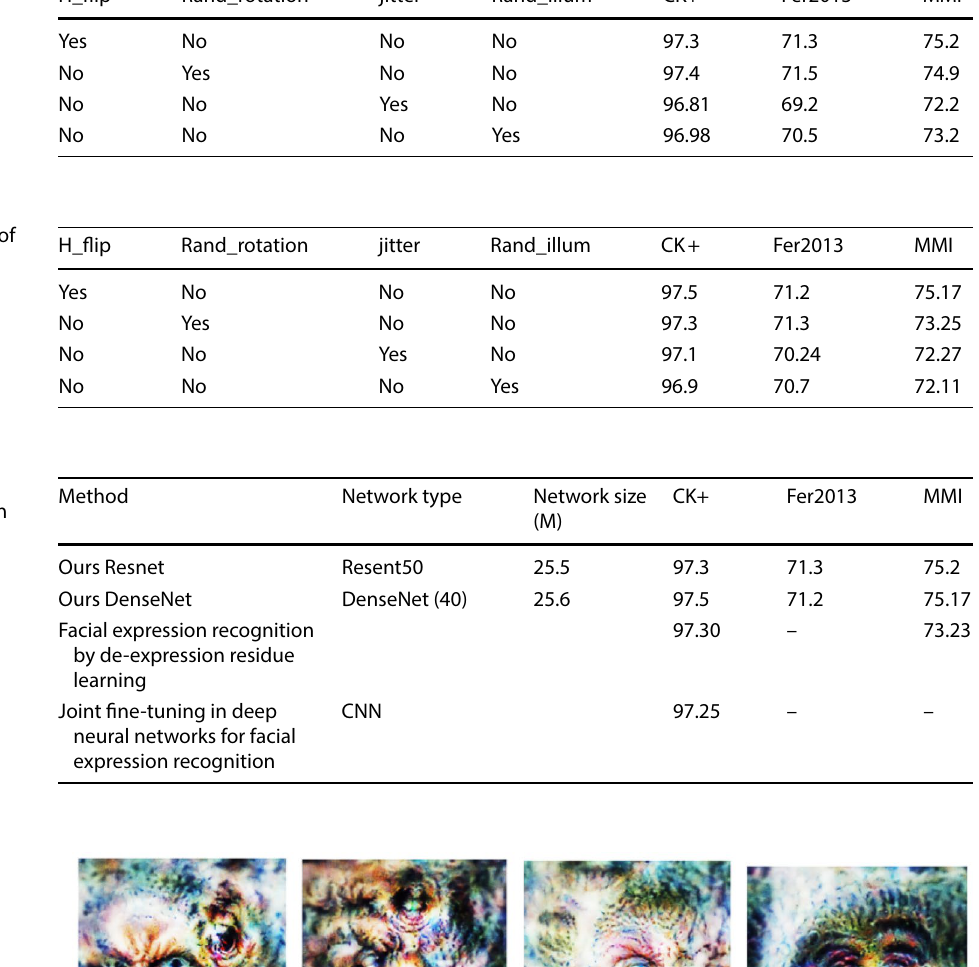
Table 5 Experimental results of Resent data enhancement